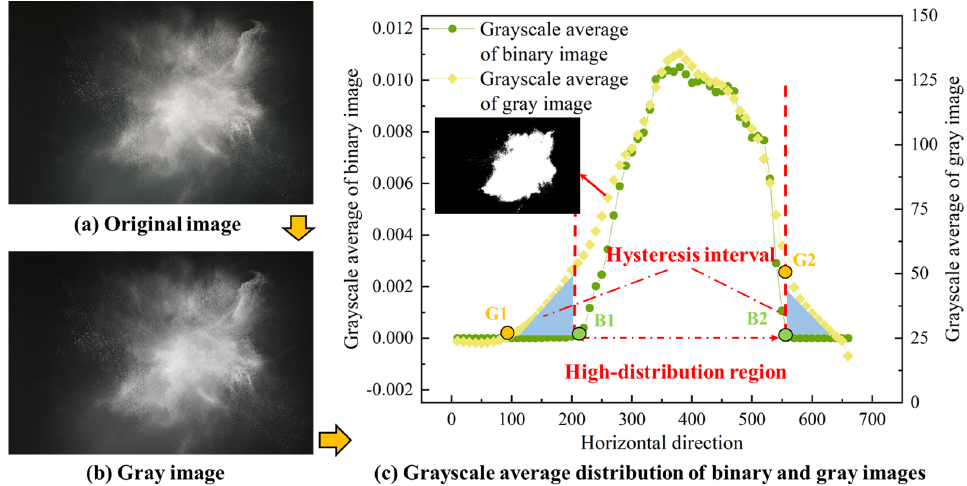
Figure 3. Result comparation on grayscale average between the binary image and grayscale image, including ( a ) original image of fugitive dust, ( b ) grayscale image, ( c ) grayscale average of binary and gray image for algorithm validation.